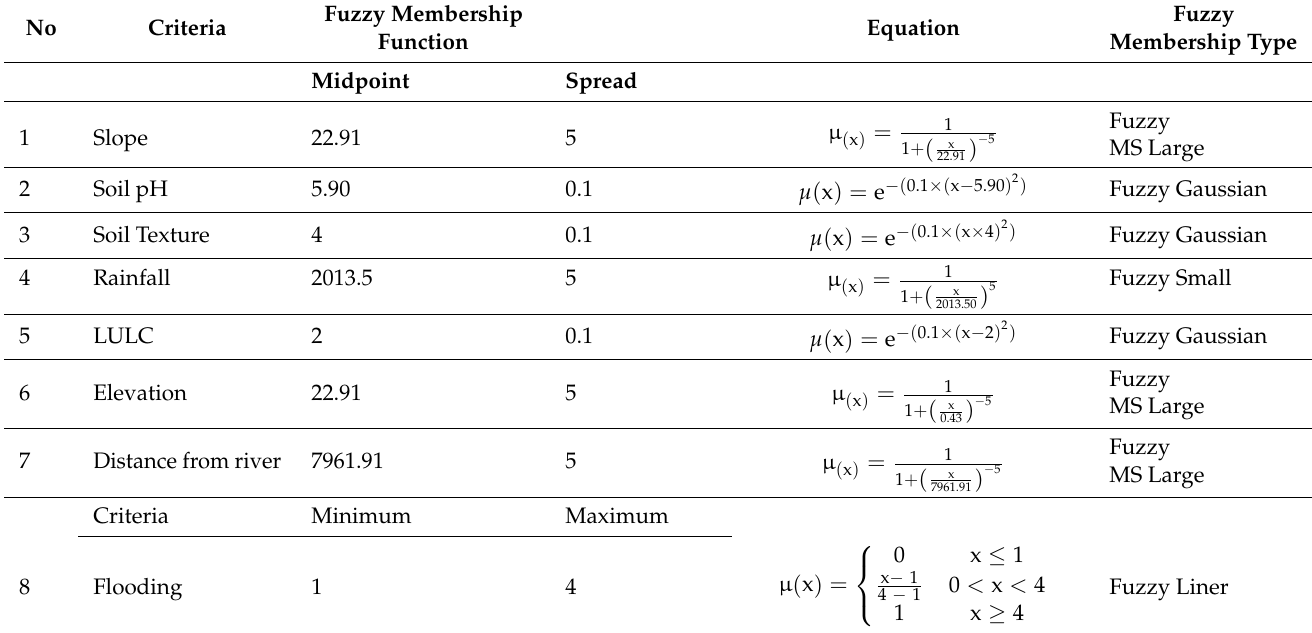
Table 4. Fuzzy membership function of land suitability analysis for sugarcane and